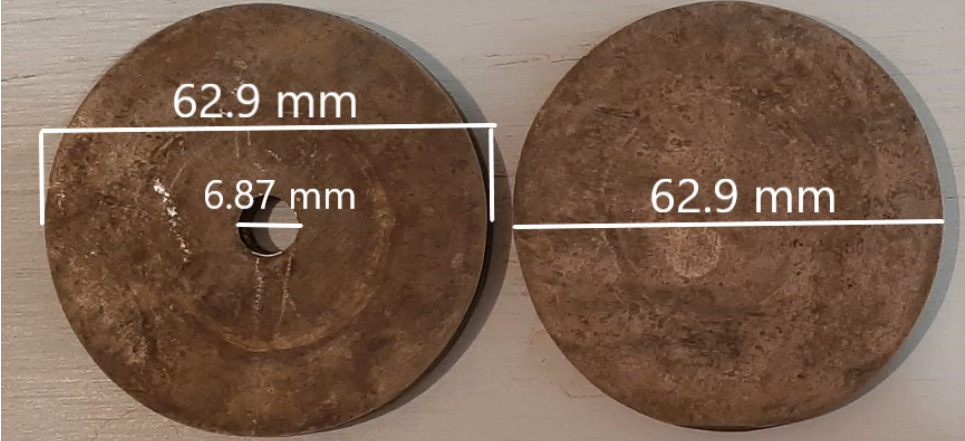
Figure 6. The steel rings used in this experiment with the one for the Hole cases on the left and the one for the No Hole cases on the right